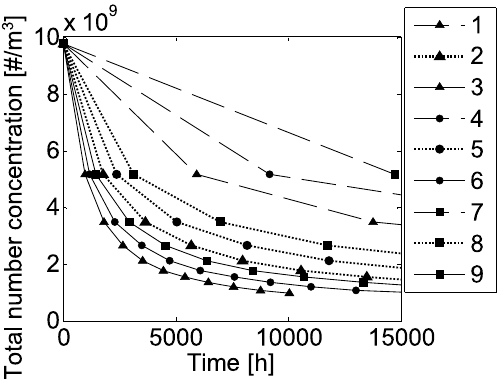
Fig. 4 Number concentration as a function of time for the different cases